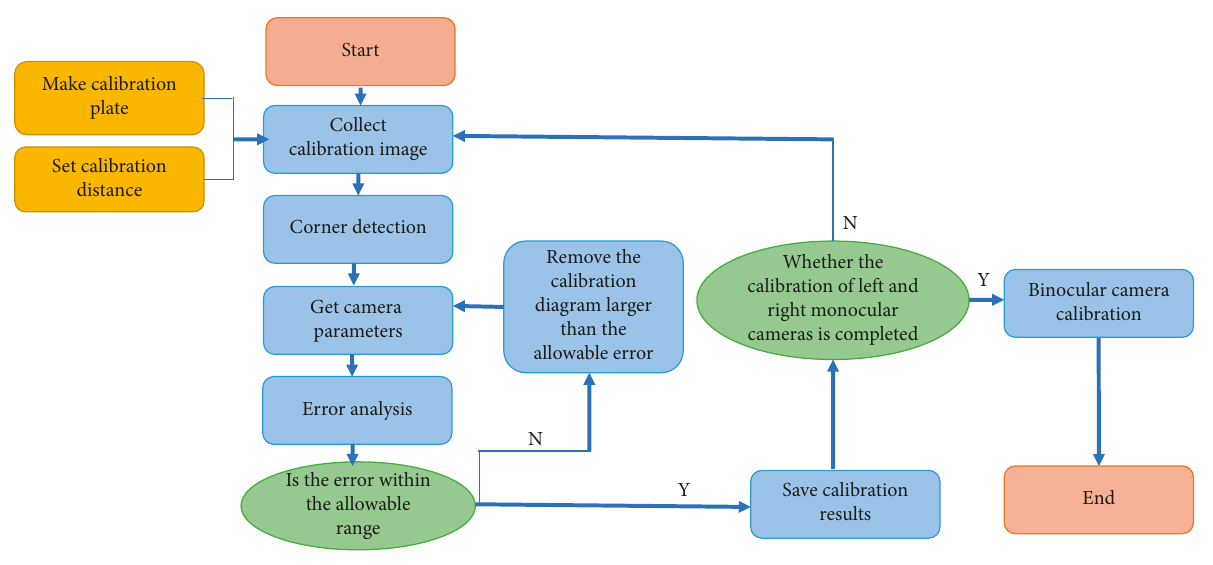
Figure 6: Flow chart of binocular camera calibration. Table 2: Average calibration error of Experiment a.